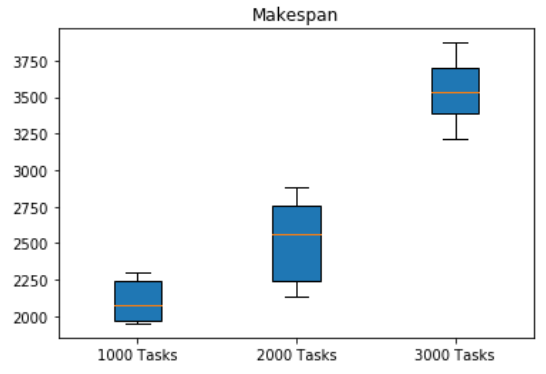
Figure 15. Makespan